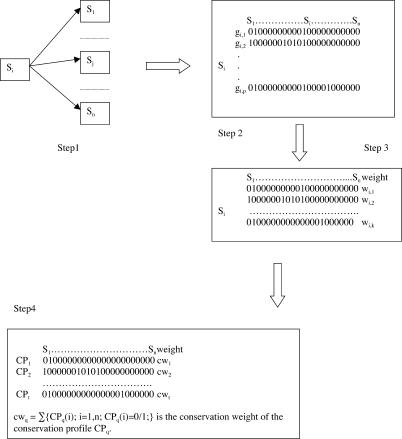
Determination of Distinct Conservation Profiles for ProteinsThe flow chart details steps in the determination of distinct conservation profiles for proteins in 99 predicted proteomes. The steps are as follows:(A) Step 1: Species-specific predicted proteome comparisons. Each protein sequence of species Si (see list in Table S1) was compared to each database of all proteins from each surveyed species, using the BLASTP program (See Materials and Methods). Best significant matches in each of the considered species were determined. The original 541,880 protein sequences, lead to 442,460 non-specific proteins (i.e., 81.7%). Fractions of ancestral duplication and ancestral conservation were determined. Each protein was then described by a vector whose components are zeros (no matches) or best significant matches whenever hits occur in each of the considered species. From the list of proteins and their corresponding best hits, pairs of orthologs were determined by looking for reciprocal best significant hits.(B) Step 2: Protein conservation profiles. In each species Si, the conservation profile of each protein k, denoted gi,k, is represented by a n-component vector of ones and zeros describing its pattern of conservation across all species. Each vector associated with a conservation profile is of size 99, corresponding to the total number of surveyed species (in the order indicated in Table S1).(C) Step 3: Distinct conservation profiles. In each species Si, identical conservation profiles were represented by a single representative, leading to the set of distinct conservation profiles. In this simplification, a “weight” is associated to a given conservation profile, as the total number of proteins with that profile. For example 3,154 distinct conservation profiles were found in S. cerevisiae, 5,690 in A. gambiae, 6,225 in H. sapiens, and 1,716 in P. falciparum.
(D) Step 4: Overall characterization of distinct conservation profiles. The overall set of distinct conservation profiles amounted to 184,130 profiles. The “conservation weight” of each conservation profile is determined, as the total sum of 1.